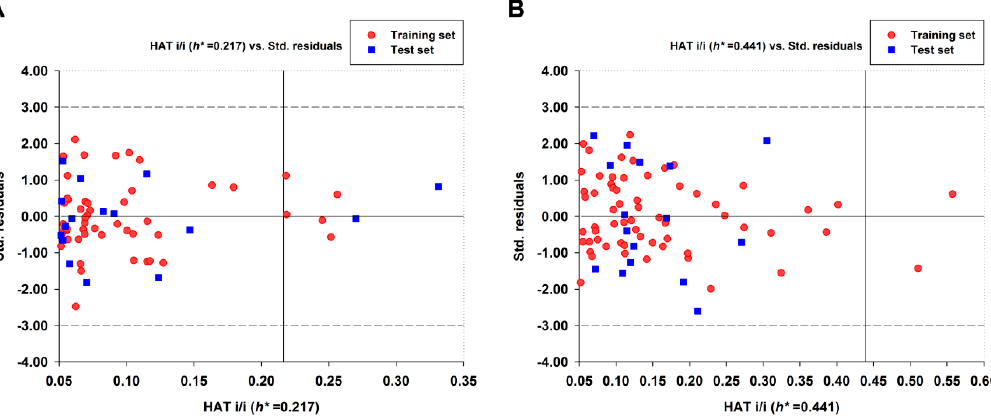
Figure 3. Williams plots for the best QSAR models based on model I ( A ) and model II ( B ). The transverse dash lines represent ±3 standard residual and vertical black line represents warning leverage h* .